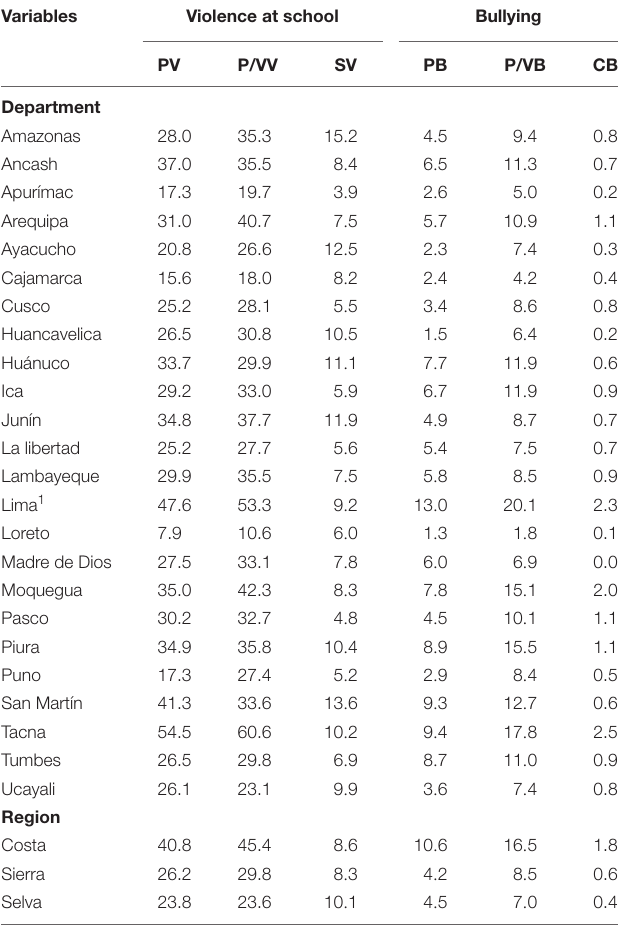
TABLE 3 | Prevalence rates by types of school violence and bullying according to departments and regions in Peru, this is the average of the all period 2014–2018. Variables Violence at school